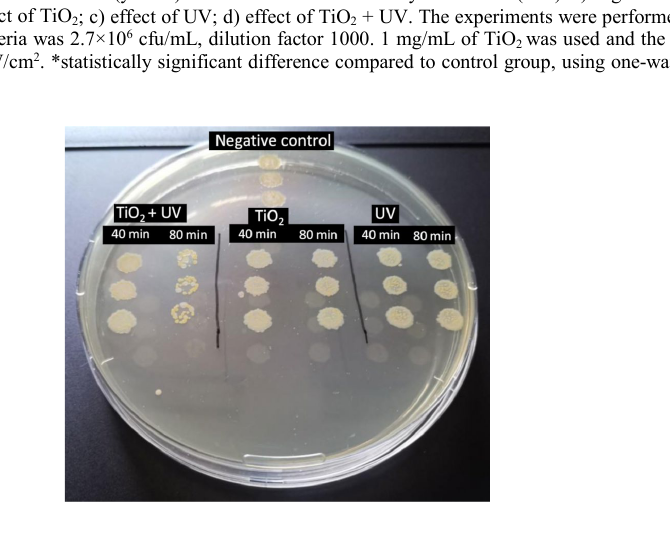
Fig. 8 The ability of E. coli and M. luteus cell mixture to form colonies assayed by DP method. Obtained results after overnight incubation at 37 °C. The results obtained for E. coli with M. luteus bacteria mixture disinfection showed